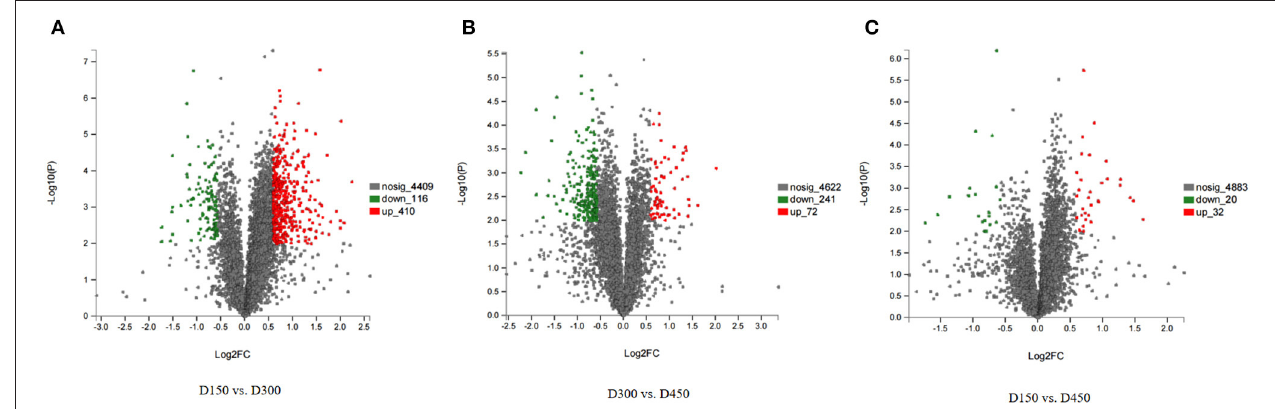
FIGURE 1 | Volcano plots of the univariate statistical analysis results. D150 vs. D300 (A) , D300 vs. D450 (B) , and D150 vs. D450 (C) . The red dots indicate significantly upregulated proteins ( P < 0.01 and FC > 1.5), and the green dots indicate significantly downregulated proteins ( P < 0.01 and FC < 0.67). The gray dots represent proteins with non-significant ( P < 0.01 and 0.67 < FC < 1.5) differences in expression.